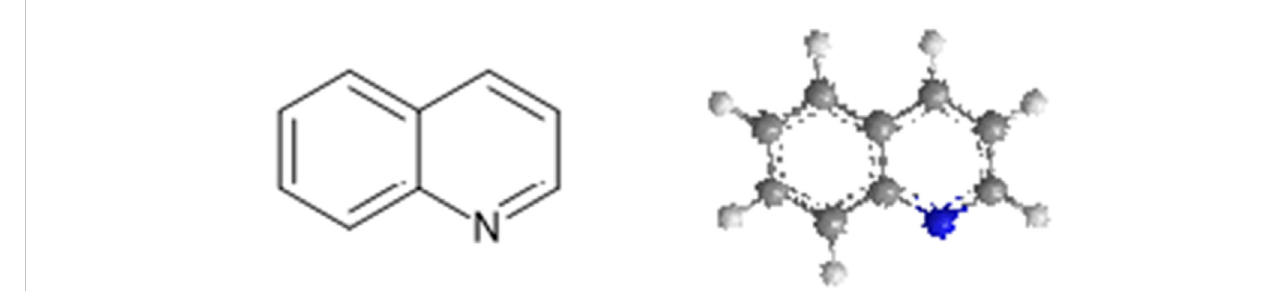
FIGURE 1 Chemical and 3D structure of quinoline.